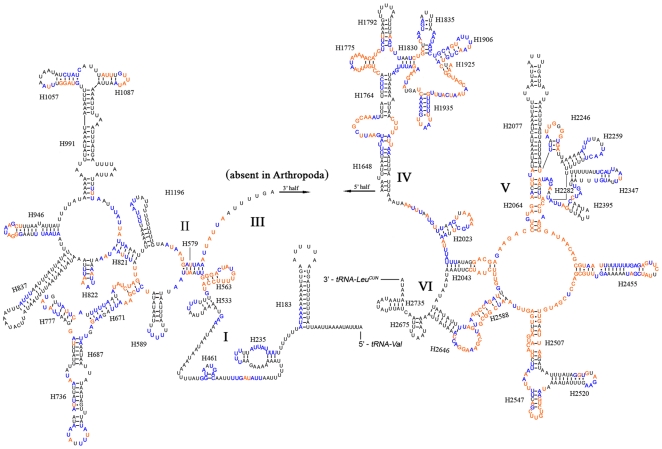
Predicted secondary structure of the rrnL gene in Stenopirates sp.The nucleotides showing 100% identities among true bugs are marked with orange color, and more than or equal to 75% identities are marked with blue color. Roman numerals denote the conserved domain structure. Inferred Watson-Crick bonds are illustrated by lines, GU bonds by dots.